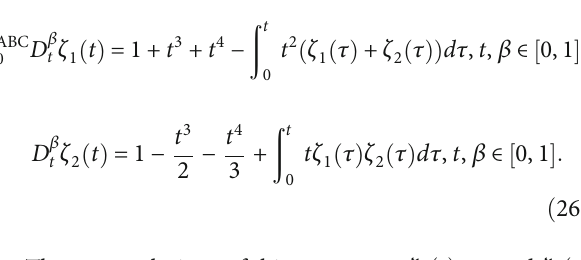
Figure 7: In (a), absolute error versus N for fractional-order β = 1 corresponding to Problem 4 for ζ versus N for β = 1 corresponding to Problem 4 for ζ